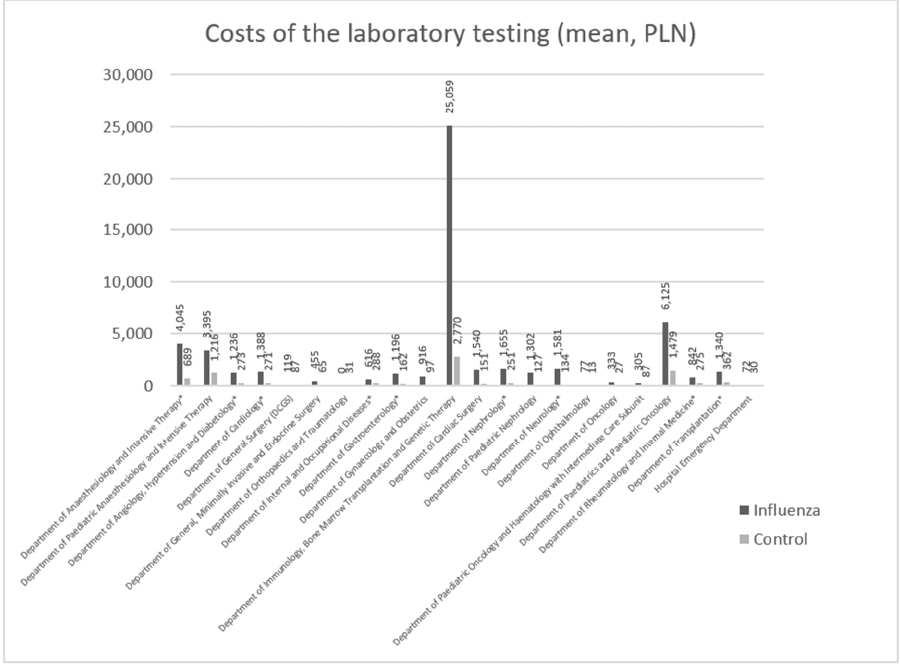
Figure 1. Mean costs of laboratory testing for the patients with confirmed influenza infection and for the control group, by hospital department (PLN) (1 PLN = 0.22 EUR). The departments with statistically significant differences between the groups ( p < 0.05) are marked with asterisks (*).